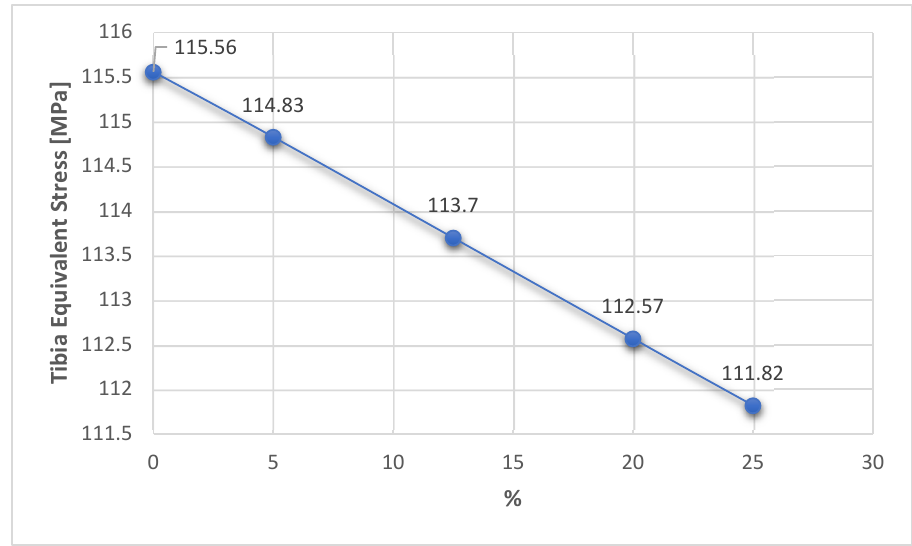
Figure 17. Variation in the tibia equivalent stress related to the overcorrection positions.